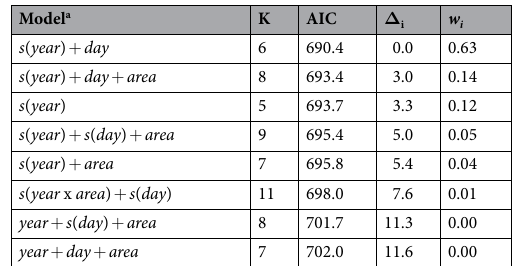
Table 2. Information criteria for comparison of candidate models for western small-footed myotis from hibernacula surveys from winter 1984–1985 to winter 2015–2016 in southern Idaho, USA; K = number